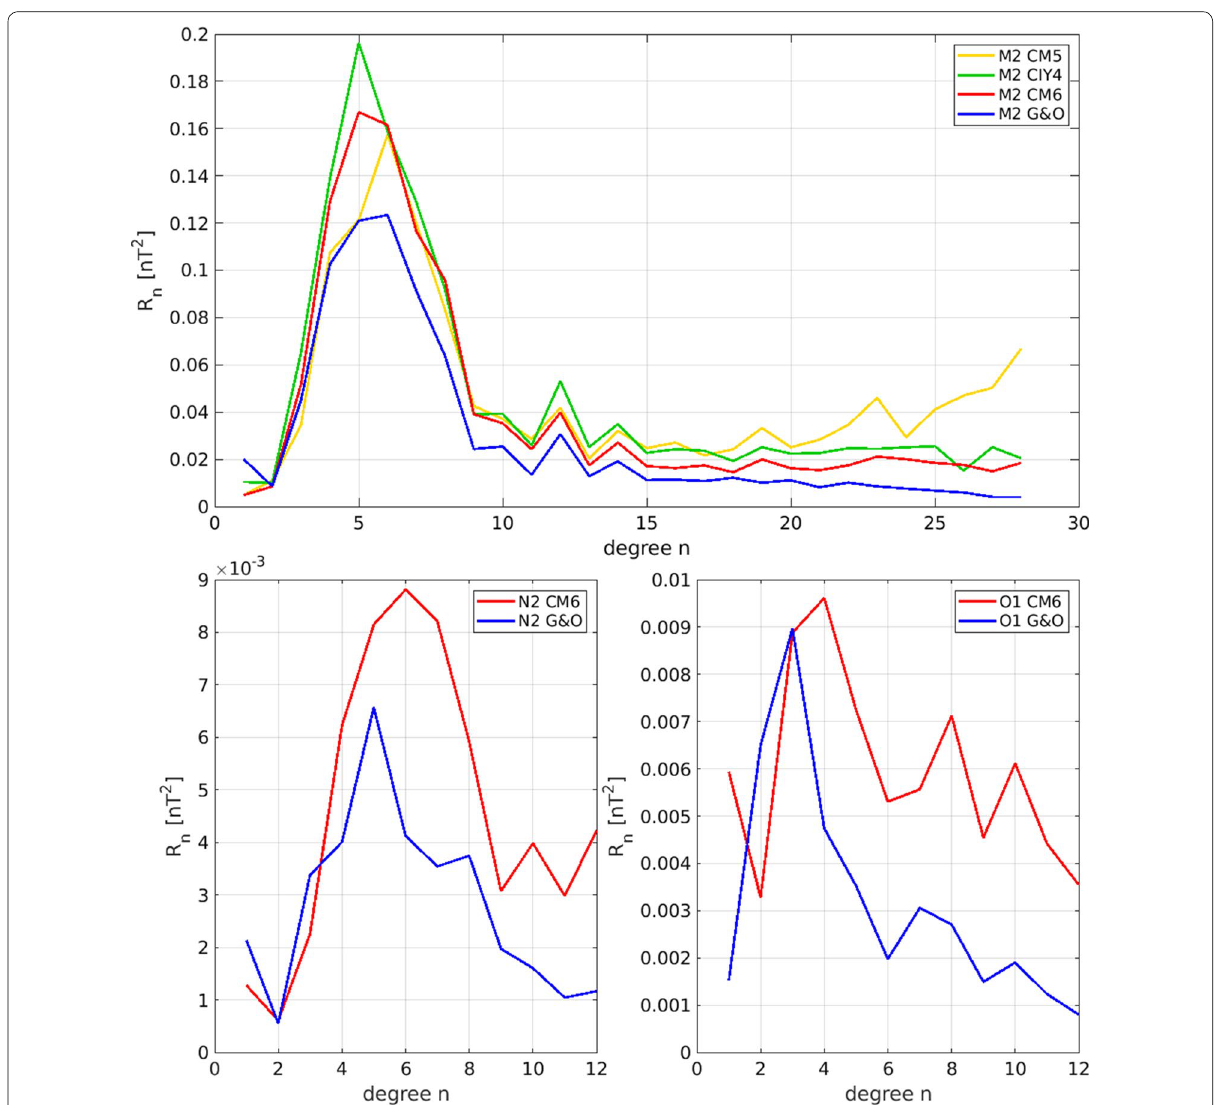
1 28 (top), of = − 1 12 (lower right), all at radius = −